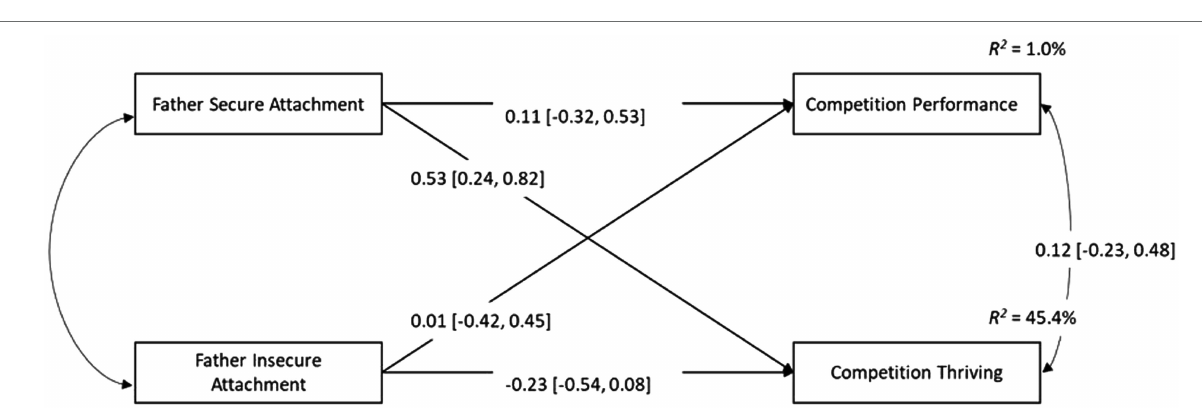
FIGURE 3 | Manifest path model displaying the relationships between father secure attachment, father insecure attachment, competition performance, and competition thriving. Standardized parameter estimates are displayed with the 95% confidence interval in